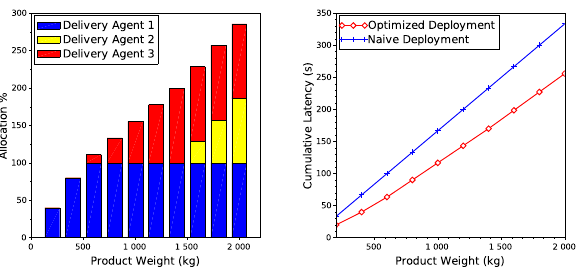
Figure 6. Allocation Ratio to Agents and Latency.